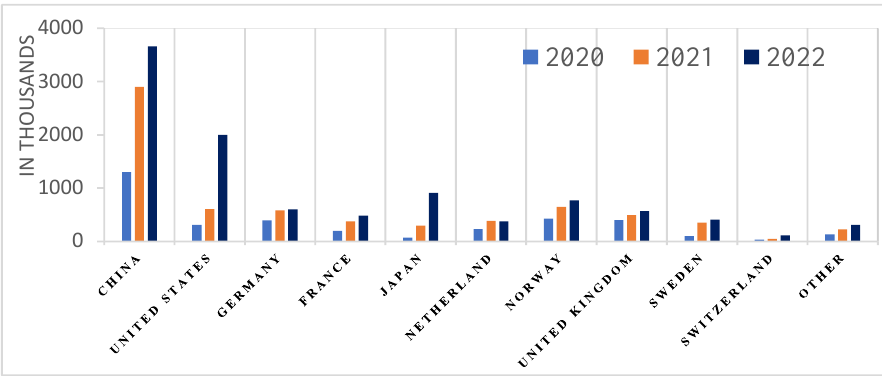
Figure 2. Electric vehicle volumes (thousands) on the road in 2020 – 2022.